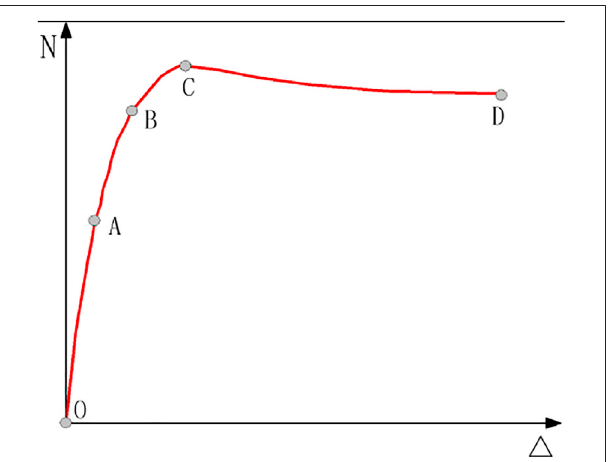
FIGURE 13 | Comparisons of load-displacement curves for specimens with different slenderness ratios.